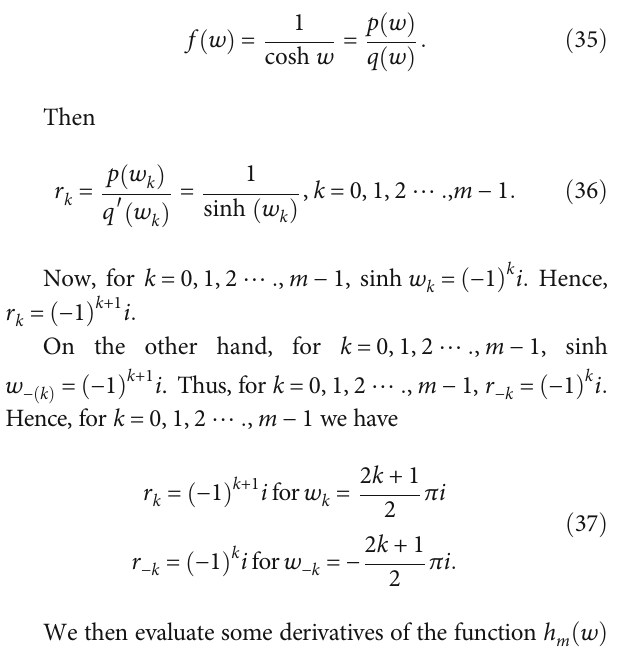
Figure 2: Solid lines represent ð TG Þ both normalized by the factor ð 1 + j x / α j n Þ